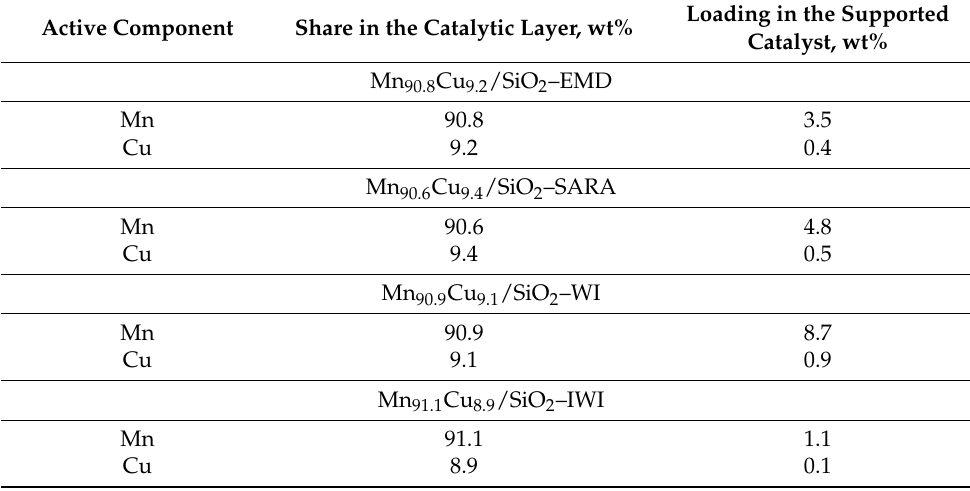
Figure 1. SEM images of the Mn–Cu oxide catalysts supported by the silica gel powder: Mn 90.8 Cu 9.2 /SiO 2 –EMD ( a ); Mn 90.6 Cu 9.4 /SiO 2 –SARA ( b ); Mn 90.9 Cu 9.1 /SiO 2 –WI ( c ); Mn 91.1 Cu 8.9 /SiO 2 –IWI ( d ); Mn 91.1 Cu 8.9 /SiO 2 –UH ( e ) and Mn 89.9 Cu 10.1 /SiO 2 –AE ( f ); 1—active species; 2—silica gel powder (carrier). Table 1. Composition of the active catalytic layer deposited on the silica gel powder by different chemical methods in a liquid phase and the loading provided by the active components (based on ICP-OES analysis).